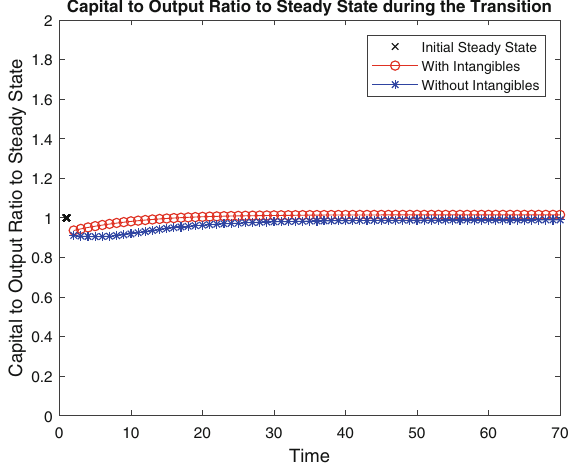
Fig. 4 Capital to output relative to initial steady state